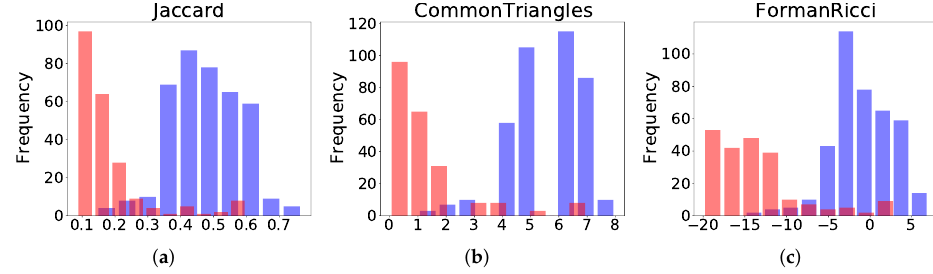
Figure 2. Distribution of link attributes in Football: ( a ) Jaccard; ( b ) CommonTriangles; and ( c )